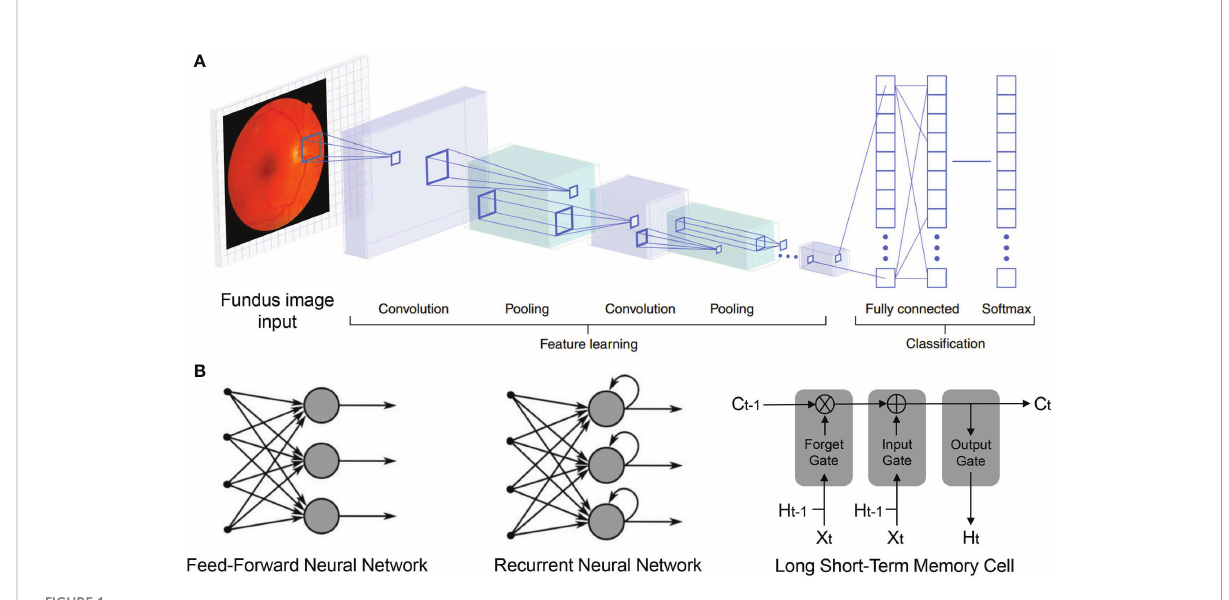
FIGURE 1 Deep neural network structures. (A) Convolutional neural network (CNN) imaging fl ow: Fundus images are input and sequentially transformed by convolution, pooling, and fully connected layers, into fl attened vectors. Output vector (Softmax layer) elements denote the probabilities for disease presence. In training, lower layers (left) learn features to in fl uence the high-level representations (right), by which internal network layer parameters are iteratively adjusted to enhance accuracy. (B) General architectures of deep learning models in